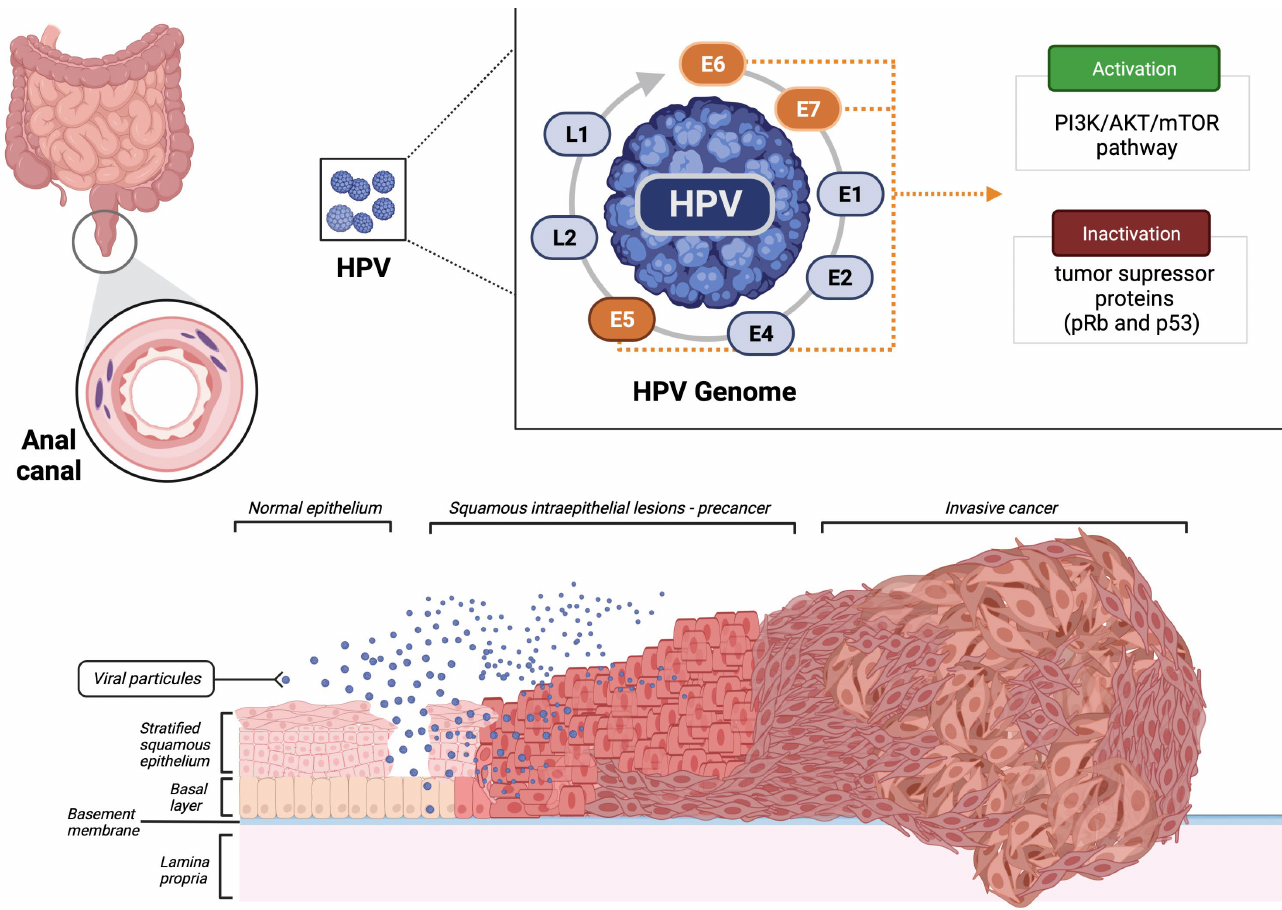
Figure 1. Malignant transformation of the normal epithelium of the anal canal by the human papillomavirus (HPV). Created using BioRender.